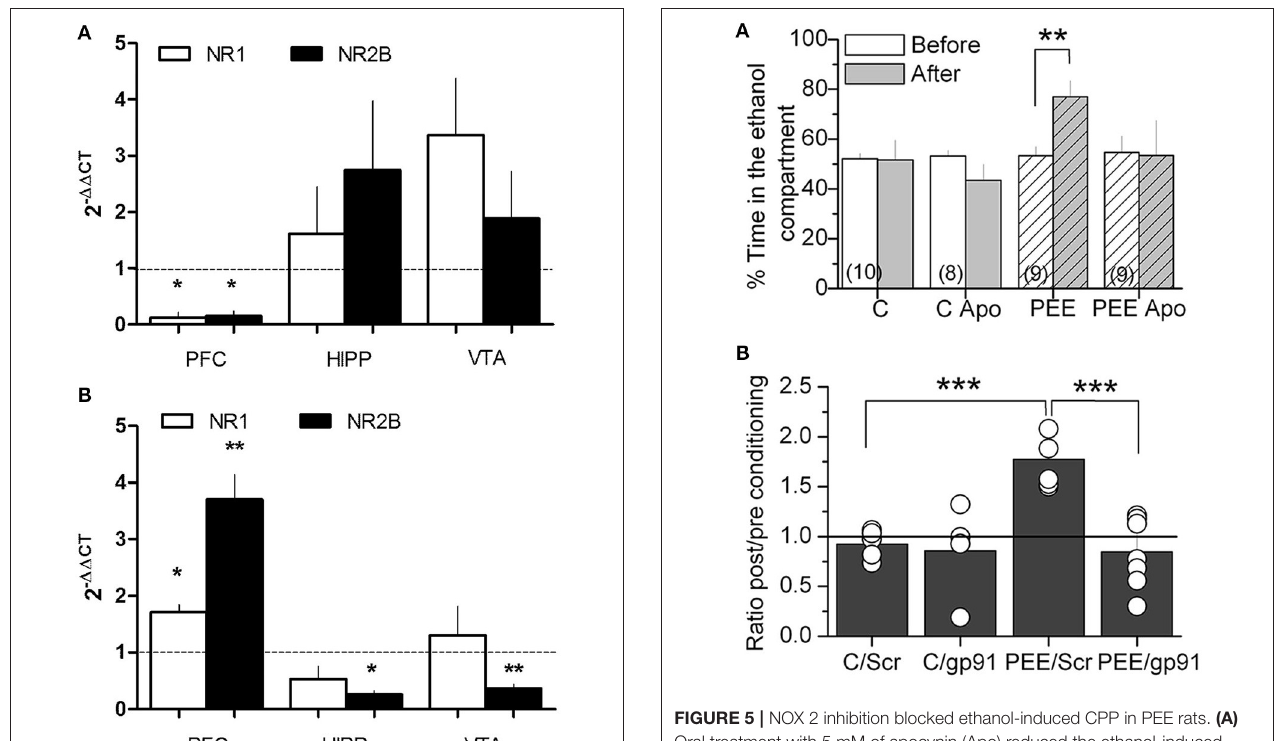
FIGURE 5 | NOX 2 inhibition blocked ethanol-induced CPP in PEE rats. (A) Oral treatment with 5 mM of apocynin (Apo) reduced the ethanol-induced CPP. (B) Stereotaxic injection of gp91 ds-tat (gp91) and not scrambled (Scr) peptides into the VTA blocked ethanol-induced CPP. Data are expressed as